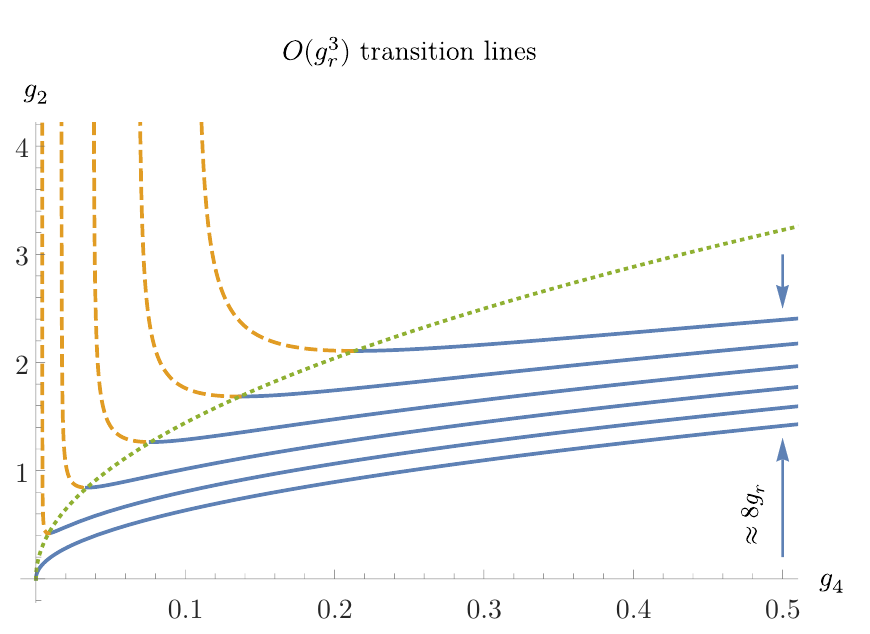
) transition line (4.8) for values g 0 . 00 , 0 . 02 , 0 . 04 , 0 . 06 , 0 . 08 , 0 . 10 } r ∈ { r √ ) = (64 g 2 3) g ) / 3 , 8(1 + 4 , g 2 r r